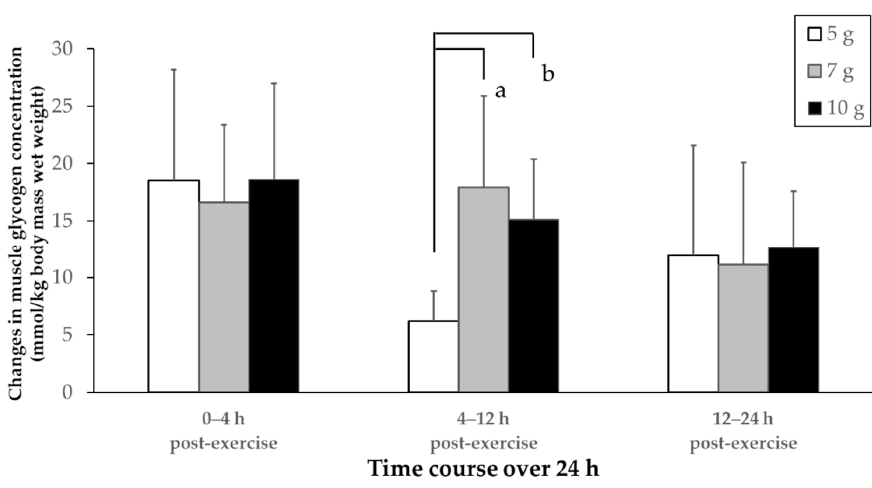
Figure 2. Changes in muscle glycogen concentration over 24 h for the three carbohydrate intake amounts—a: 5 g group, b: 7 g group, c: 10 g group, vs. pre-exercise; p < 0.05; values are expressed as mean ± standard deviation.